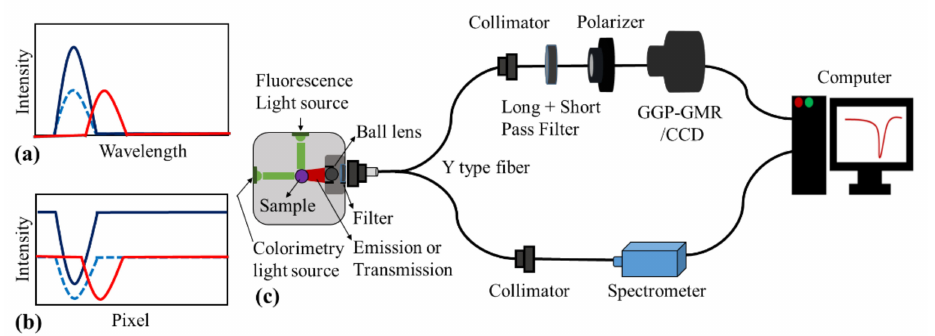
Figure 2. ( a ) Illustration of the incident spectrum for the GGP-GMR device, ( b ) intensity distribution on the CCD of the GGP-GMR device, and ( c ) experimental setup for the fluorescence and colorimetric assay